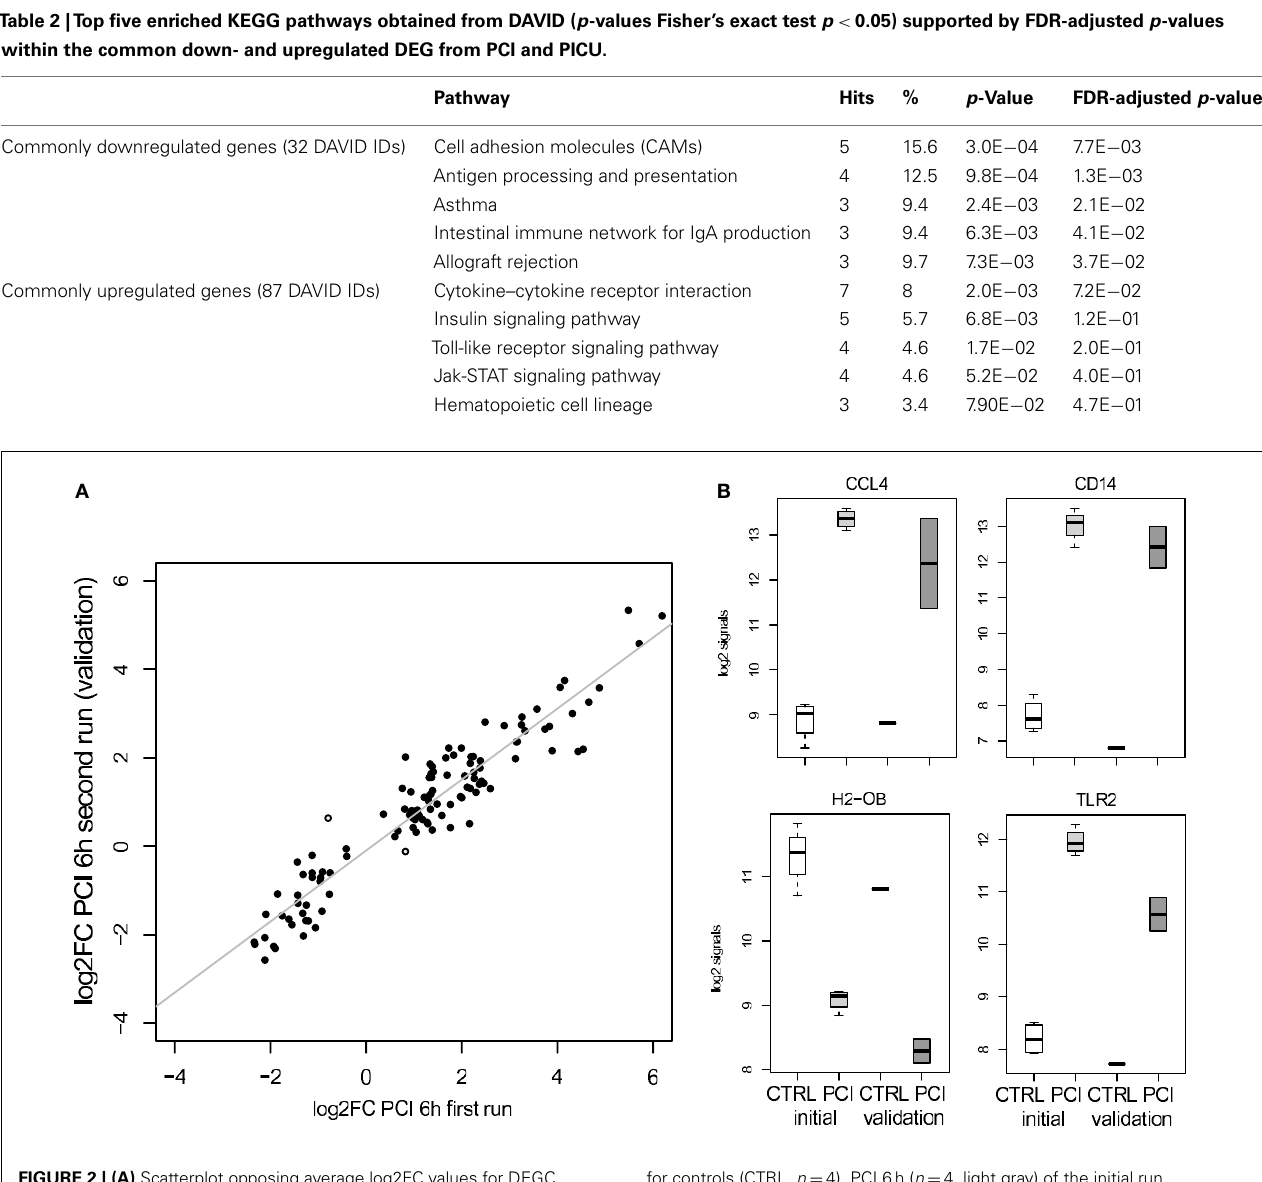
FIGURE 2 | (A) Scatterplot opposing average log2FC values for DEGC ( n = 115) in PCI for the 1st and 2nd run.Two spots with different signs for log2FC values are marked. (B) Gene-centered log2 signal values